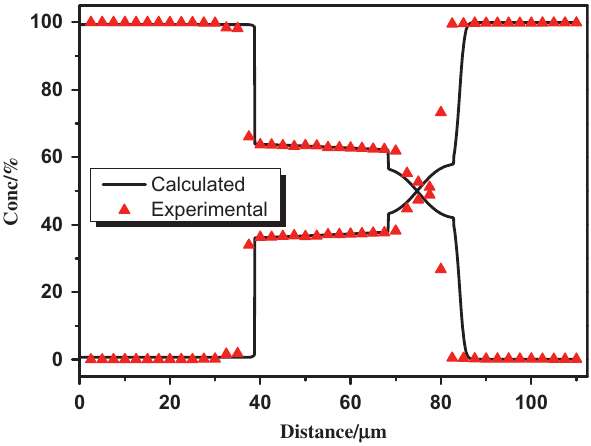
Figure 6: Relations between the experimental results and the cal- culated of concentration